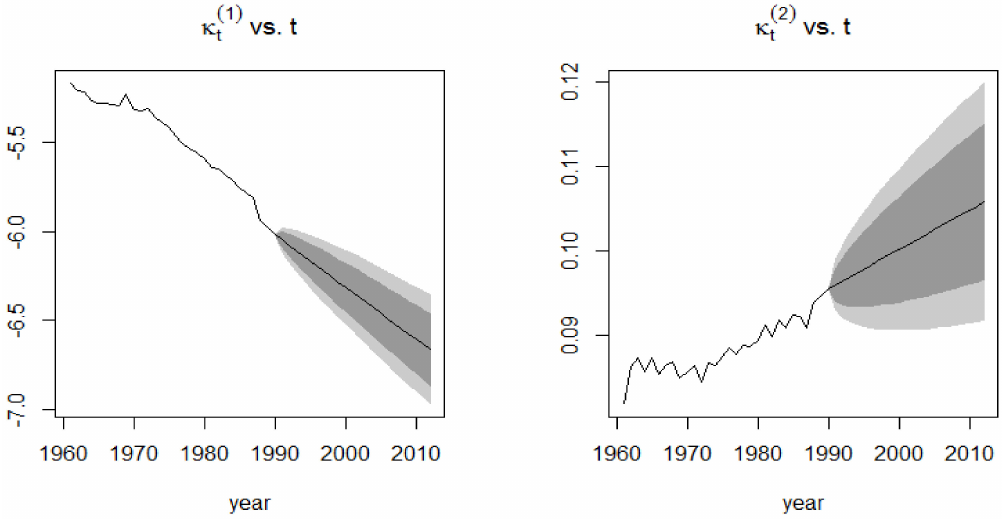
Figure 11. Forecasts of the two time-dependent parameters of the CBD model for the 1991–2015